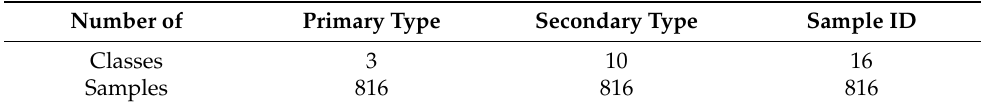
Table 1. Summary of biomass classification problems.